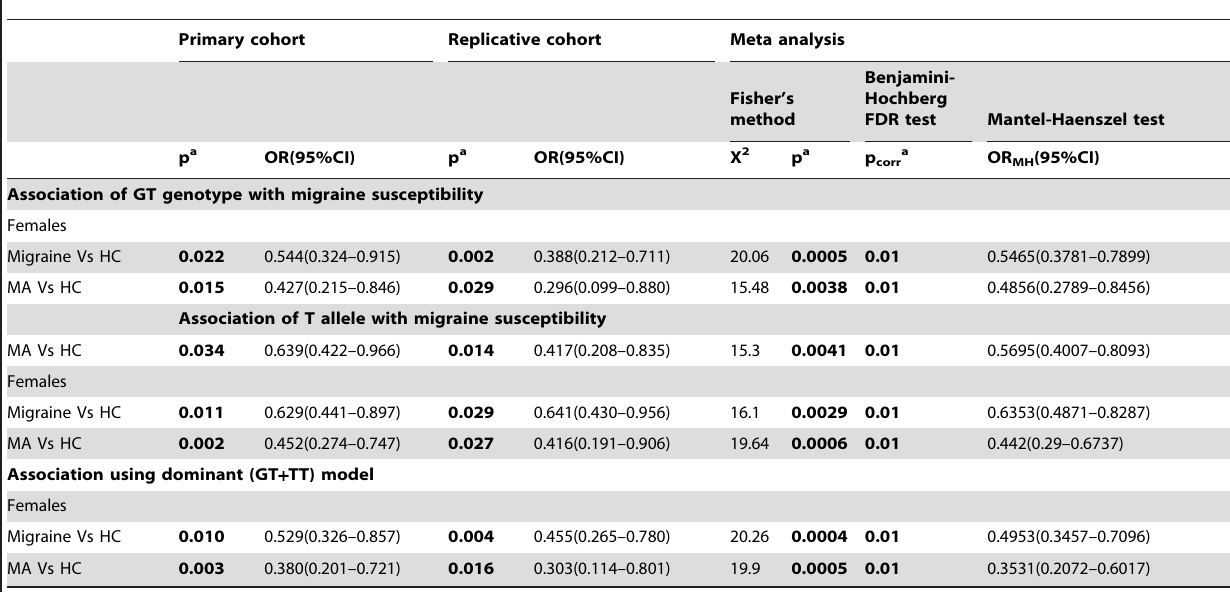
Table 2. Association study of CYP19A1 rs4646